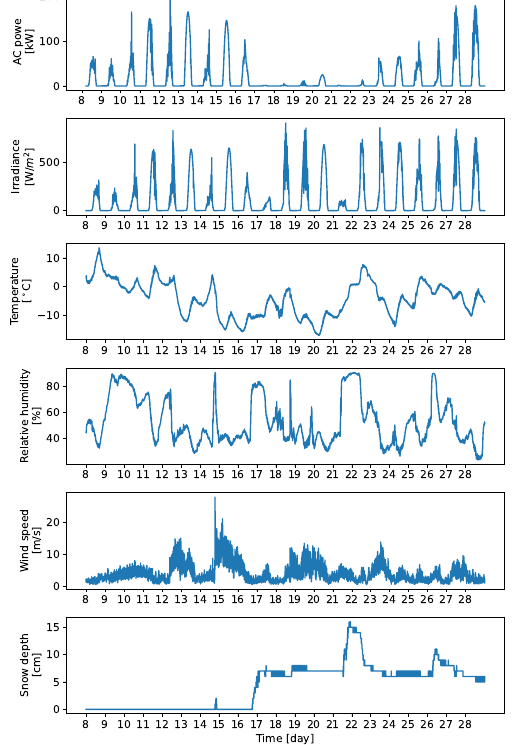
Figure 6. Profiles of power generation and local weather for 21 days in February 2015. In addition, we observed some inverter faults in the dataset, and they were labeled by an expert who was managing the PV systems. It was also observed that AC power, current and voltage sharply decreased and increased in the PV system within a short time period, while irradiance showed a normal pattern, as illustrated in Figure 7.